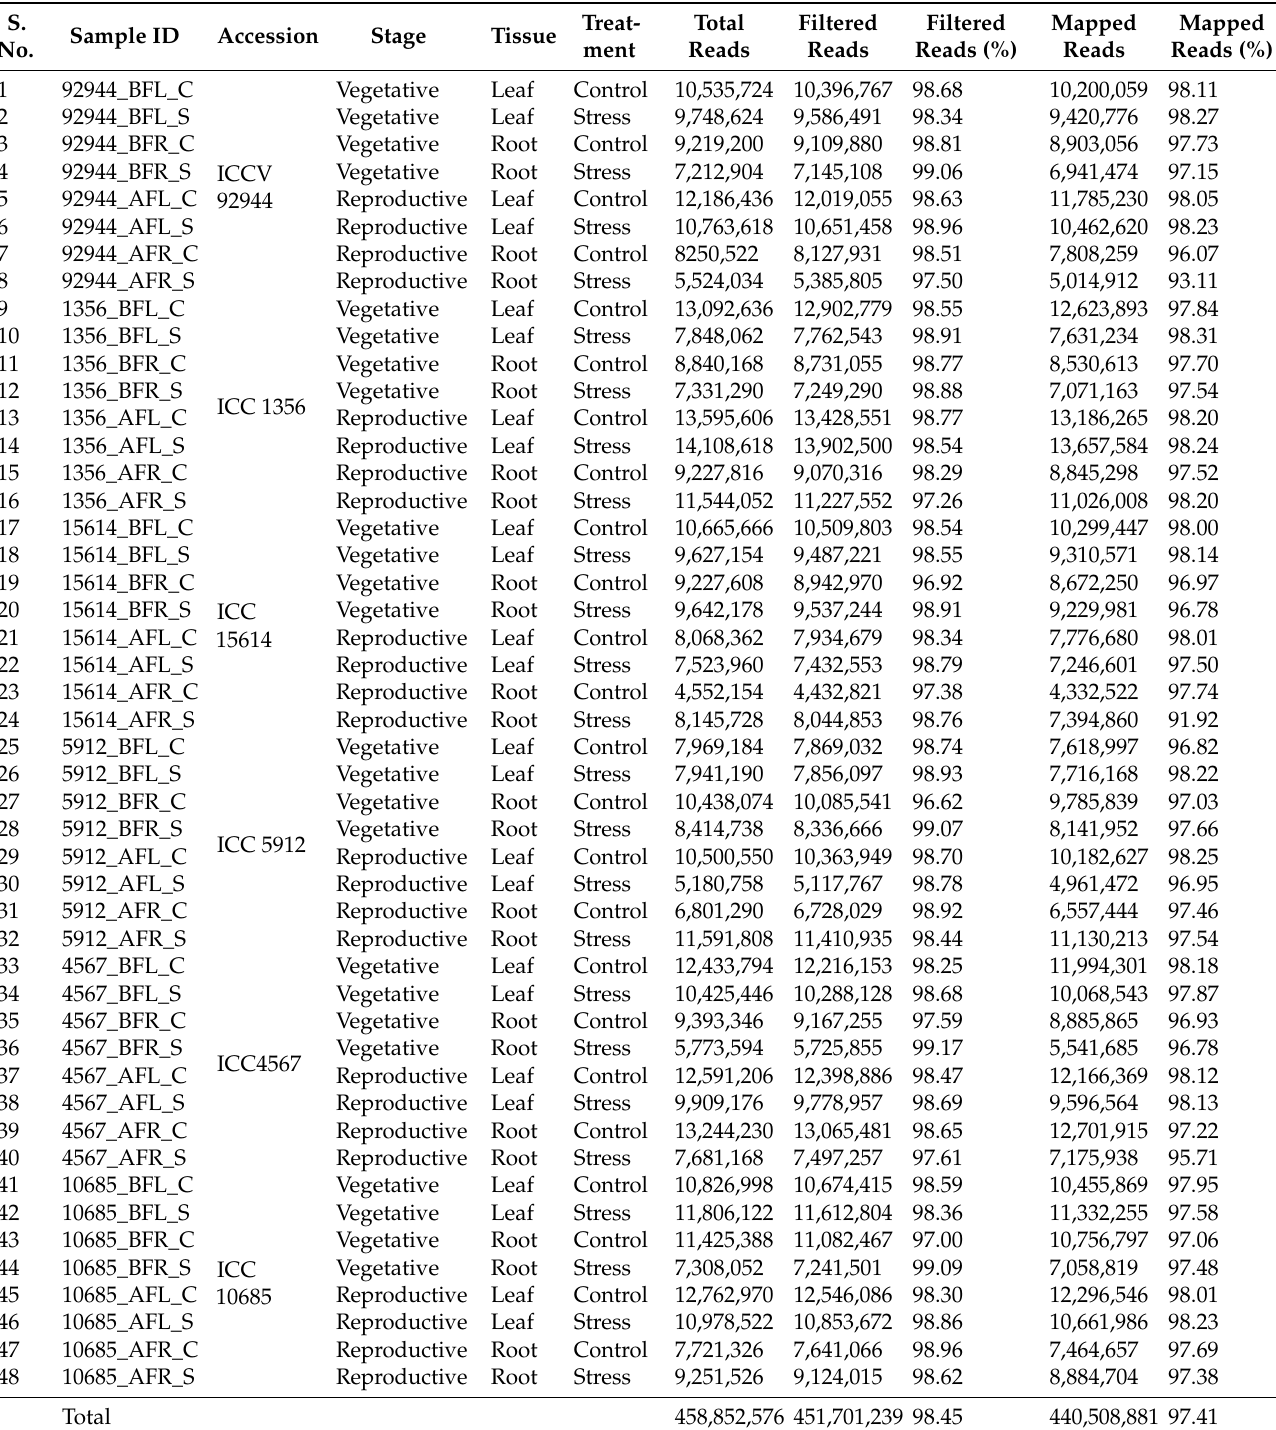
Table 1. Summary of the Illumina sequencing data and read statistics of the